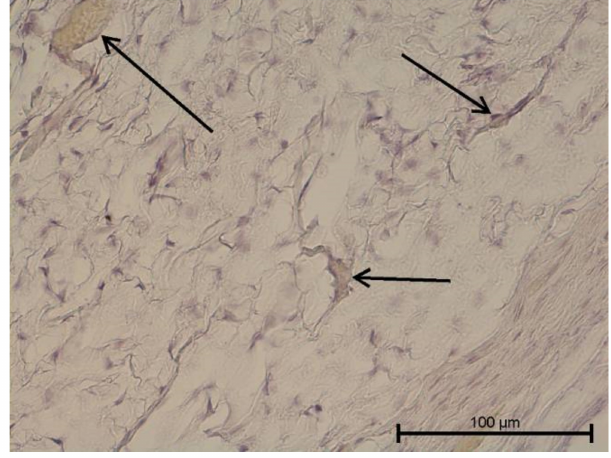
Figure 10. Light microscope image. Carious tooth. Anti-PDPN—positive (black arrow). Single leukocytes visible. Mag. 400 × .